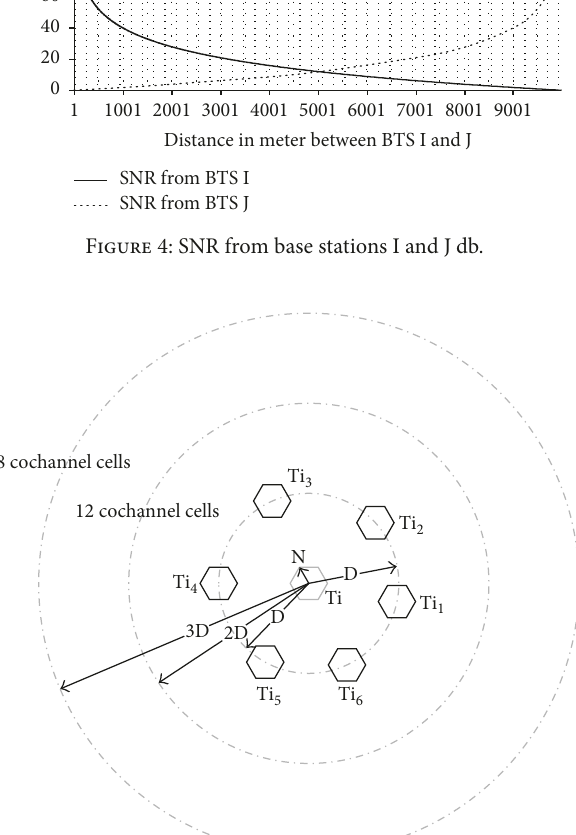
Figure 5: Geographical model for several tiers of interfering BTS